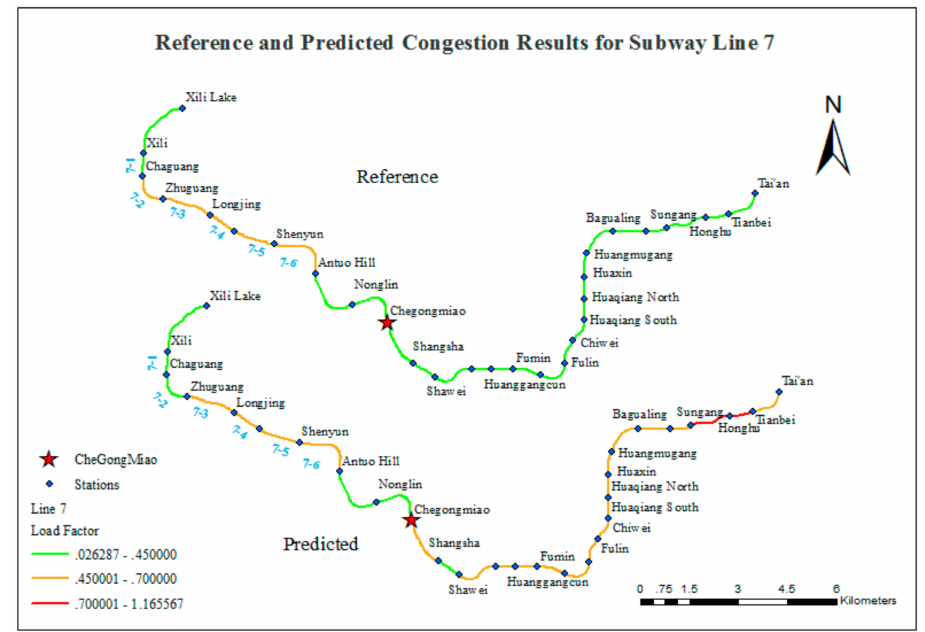
Figure 15. Comparison of reference and predicted congestion results for Line